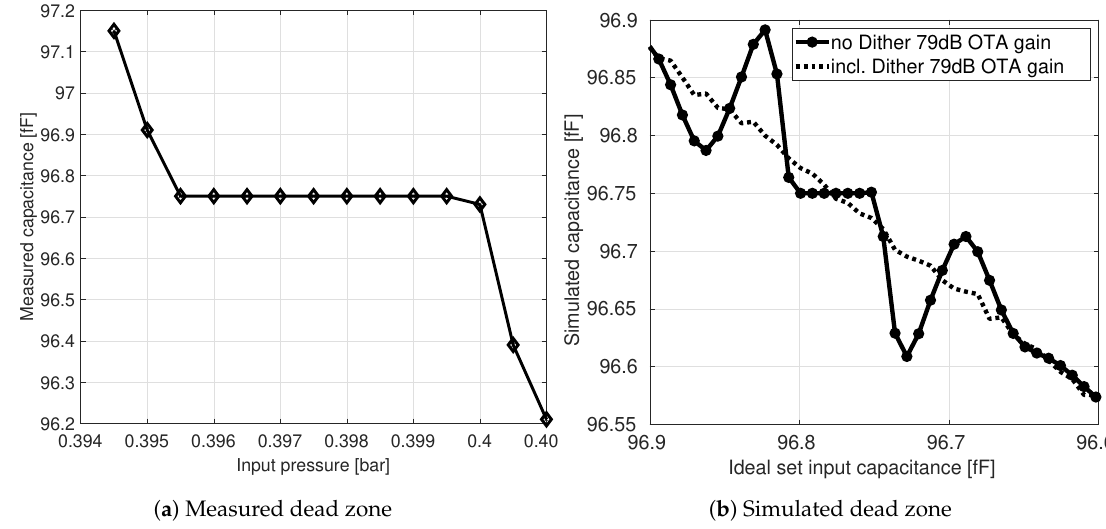
Figure 14. Dead zone example within measurement around 400 mbar of a real pressure sensor MEMS bridge ( a ); Simulated dead zone with and without added dithering ( b